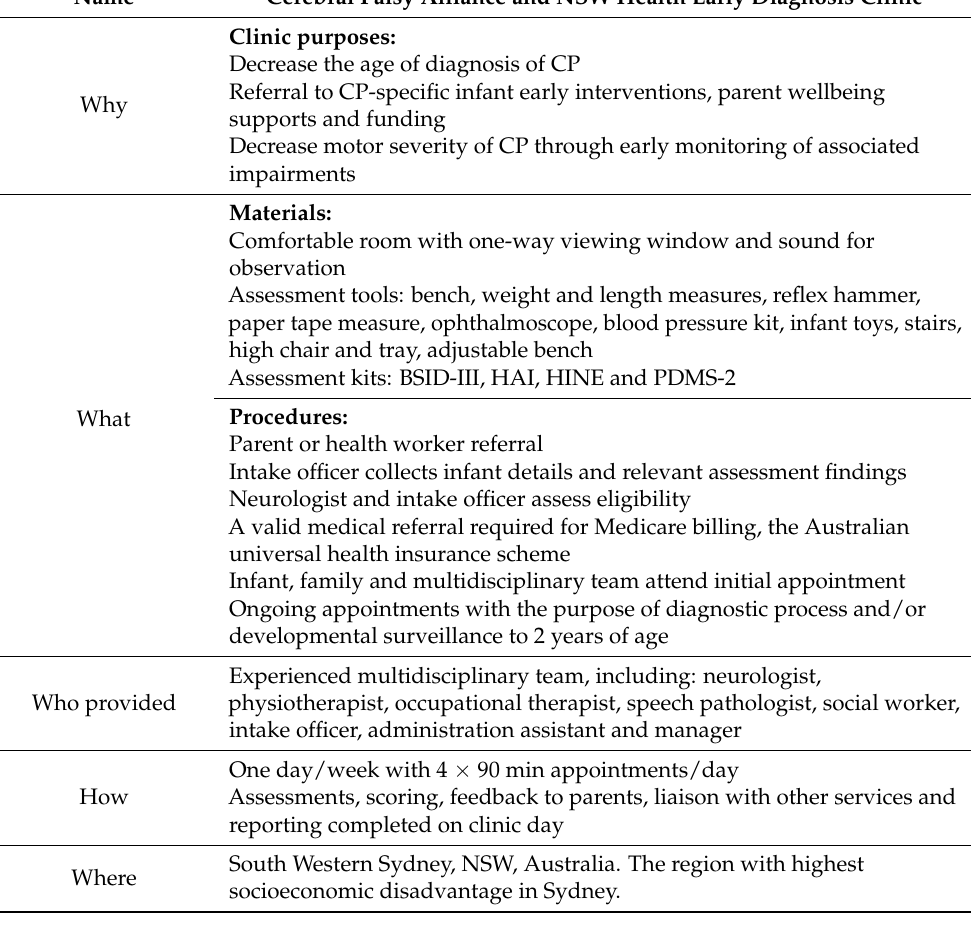
Table 1. Description of clinic based on Template for Intervention Description and Replication (TIDieR